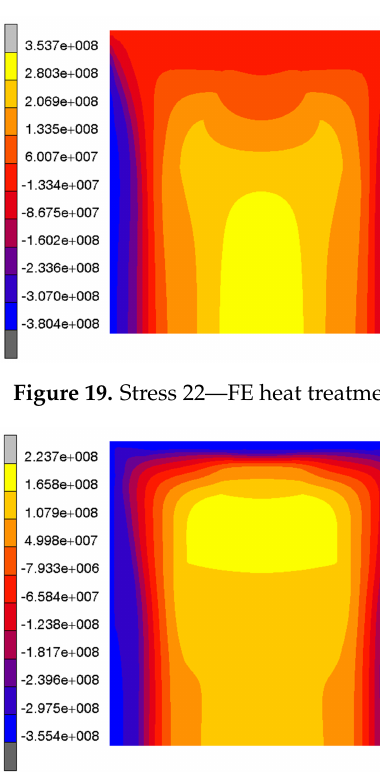
Figure 18. Stress 11—FE heat treatment.